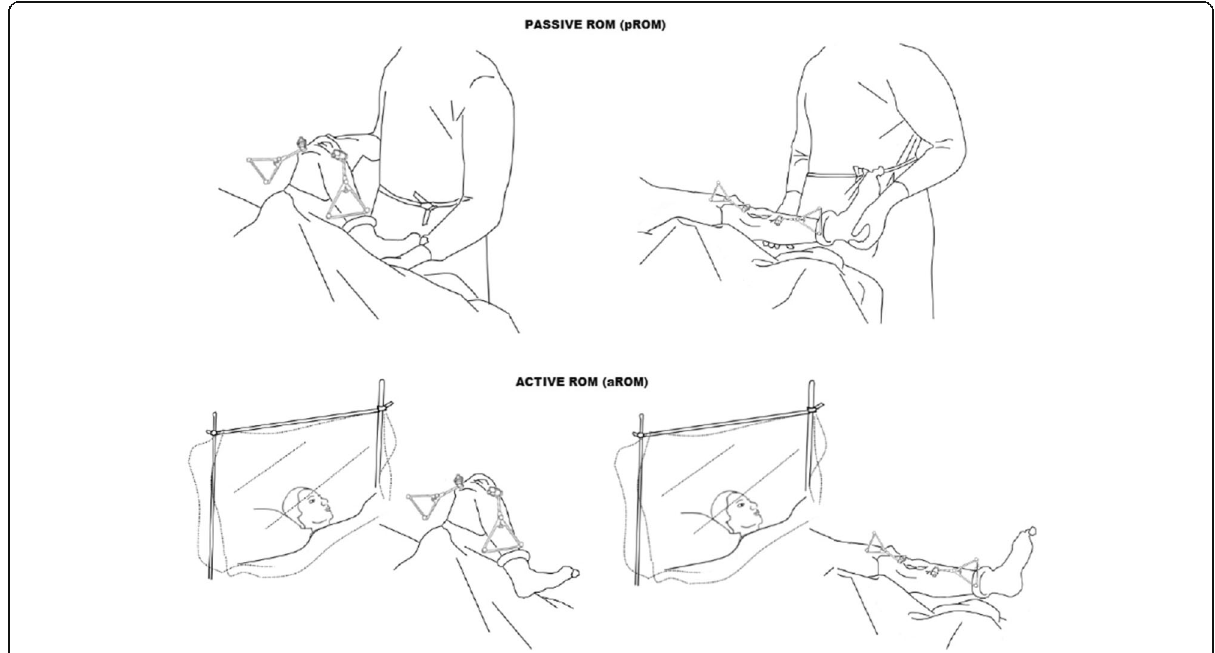
Fig. 2 pROM: Passive flexion-extension movement performed by the surgeon (A). aROM: Active flexion-extension movement performed by the patient during surgery in CSE